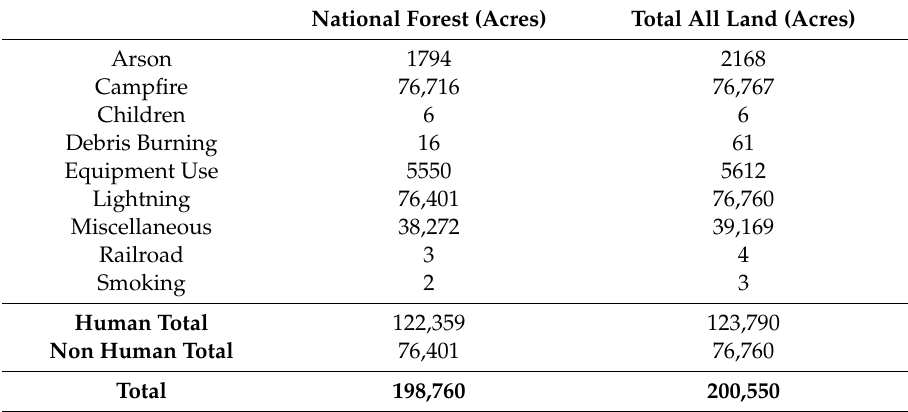
Table 3. Sample of USFS fire cause data: California, 2012. Source: United States Forest Service (USFS). National Forest